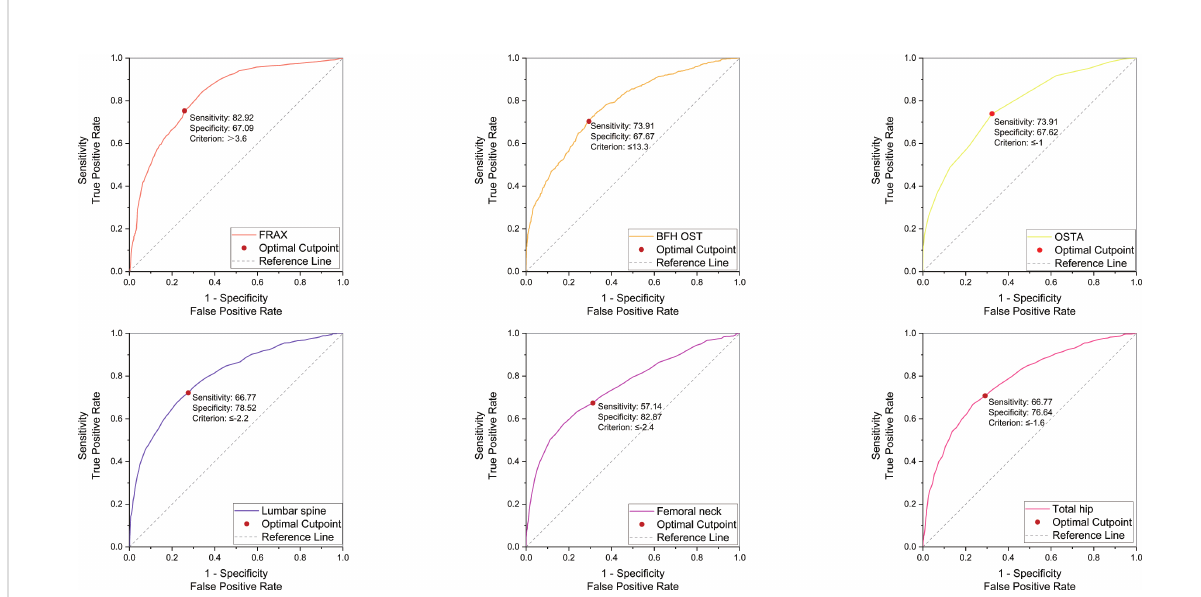
FIGURE 3 ROC curve of the FRAX without BMD, BFH-OST, OSTA, and BMD T-score (femoral neck, total hip, and lumbar spine) for identifying PNOVFs with optimal cutoff